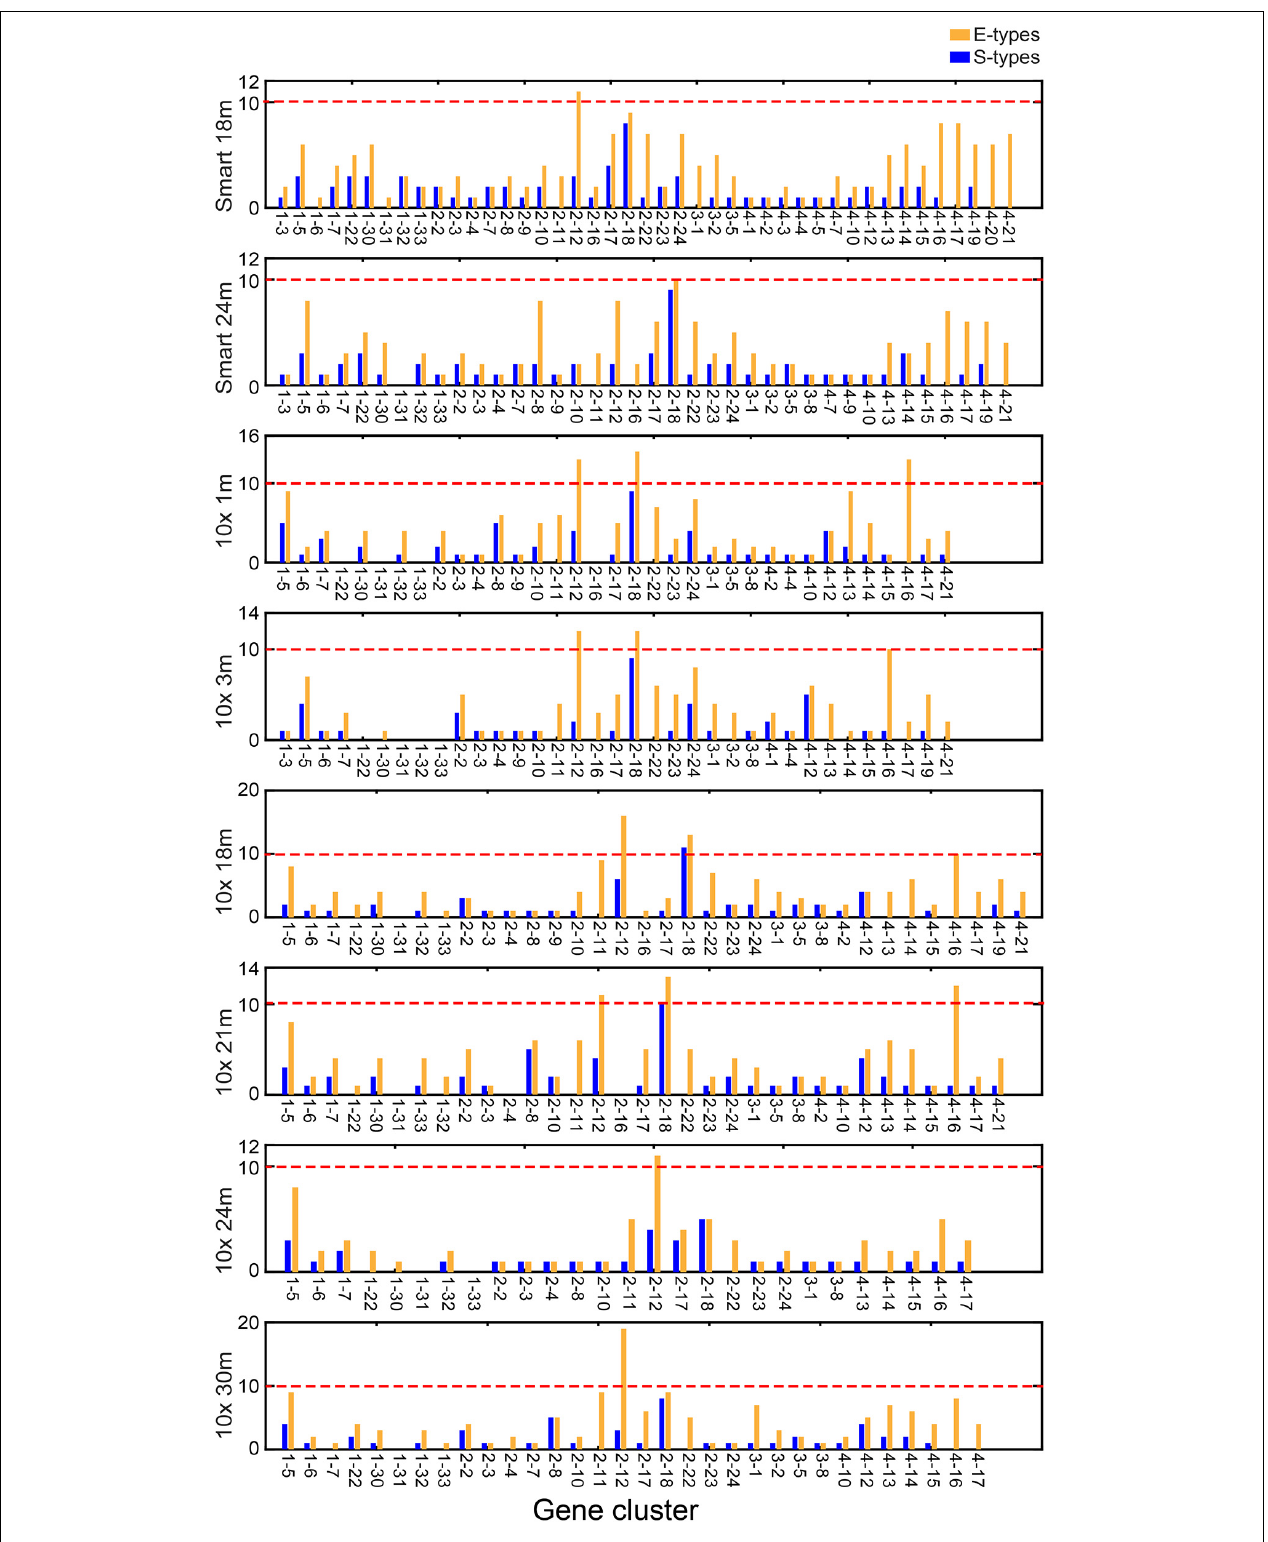
FIGURE 3 | Number of S types and E types associated with each CTS gene cluster in the validated the single-cell RNA sequencing (scRNA-Seq) data. “Smart 18m” and “Smart 24m” represent the scRNA-Seq data using the SMART-Seq2 platform in 18- and 24-months-old mice. “10x 1m,” “10x 3m,” “10x 18m,” “10x 21m,” “10x 24m,” and “10x 30m” represent the scRNA-Seq data using the 10x Genomics platform in 1-, 3-, 18-, 21-, 24-, and 30-months-old mice.